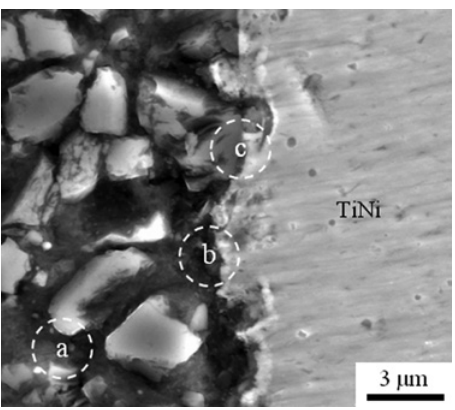
Figure 10 Strain of the SiC temperature in the heating